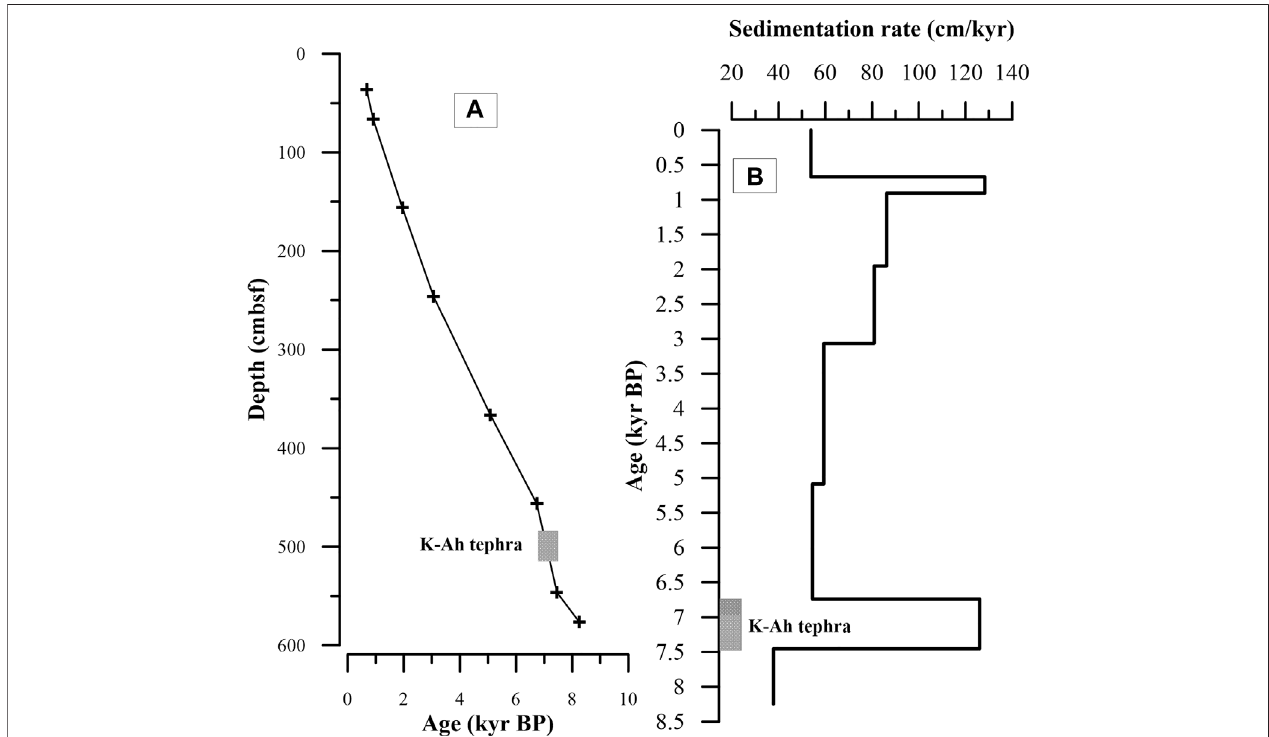
FIGURE 2 | (A) Age-depth model of core C14; (B) sedimentation rates of core C14.